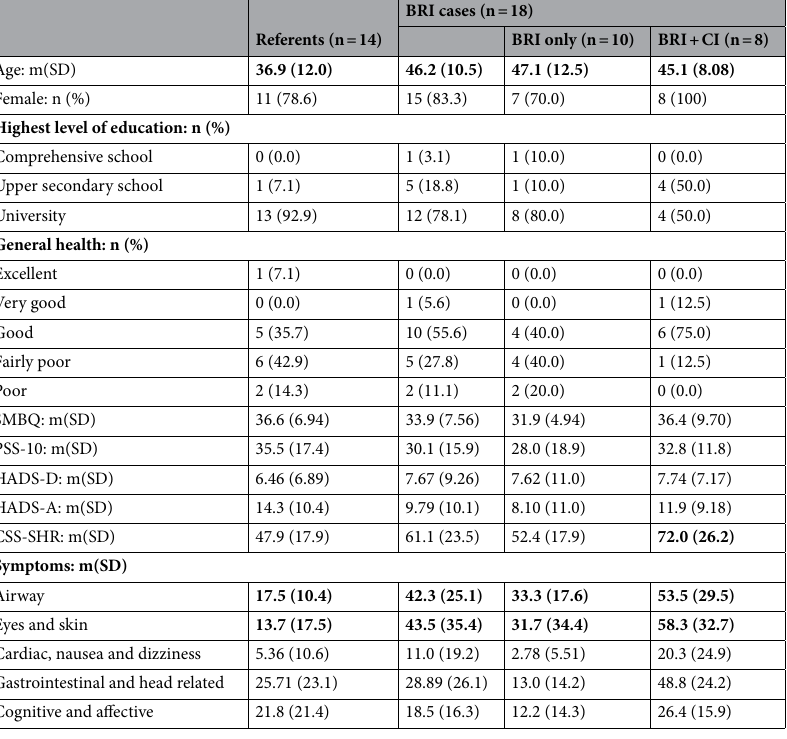
Table 1. Characteristics of the participants. Significant values are in bold. SMBQ = Shirom Melamed Burnout Questionnaire, PSS-10 = Perceived Stress Scale of ten questions, HADS-D = Hospital Anxiety and Depression Scale-Depression subscale, HADS-A = Hospital Anxiety and Depression Scale-Anxiety subscale, CSS- SHR = Chemical Sensitivity Scale for Sensory